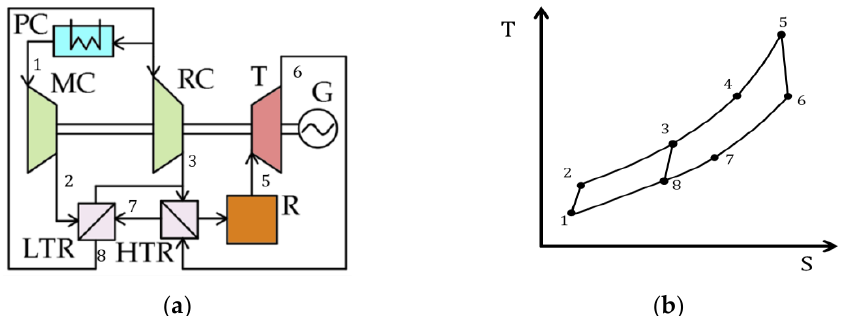
Figure 6. Supercritical CO 2 Brayton cycle with recompression: ( a ) schematic diagram; ( b ) T – S diagram [12]. R — reactor; T – turbine; G — generator; HTR — high-temperature regenerative heat exchanger; LTR — low-temperature regenerative heat exchanger; PC — precooler; MC — main compressor; RC — recompression compressor.